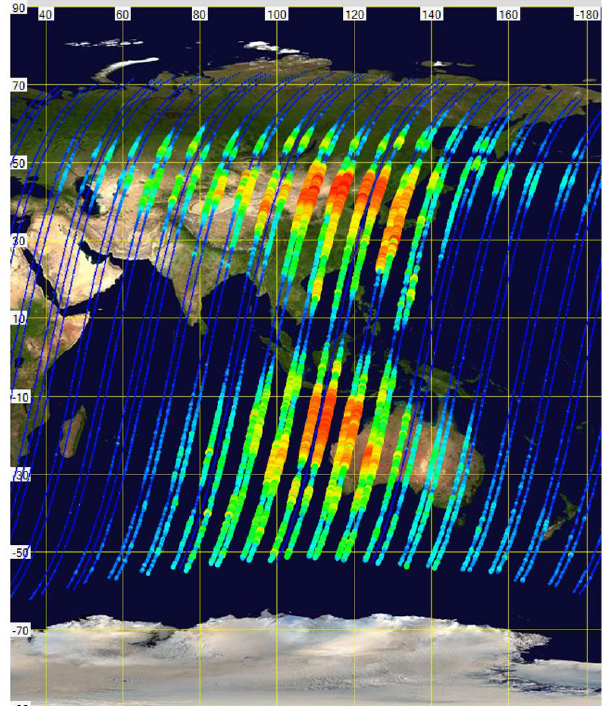
Figure 3. The electric field disturbance (signal-to-noise ratio) in the southern and northern magneto-conjugate regions above the Naval Communication Station Harold E. Holt (denoted NWC) VLF trans- mitter with operational frequency